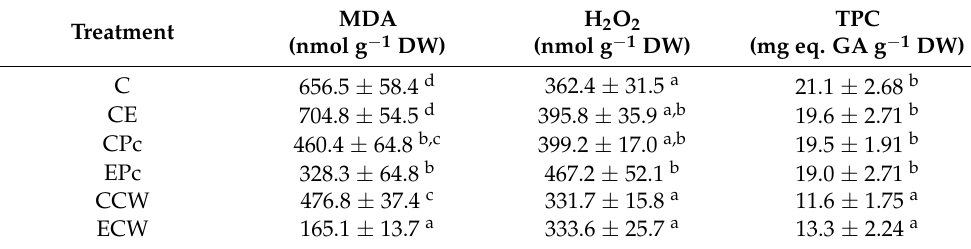
Table 6. Effect of soil treatments on oxidative stress markers and non-enzymatic antioxidants. MDA: malondialdehyde, H 2 O 2 : hydrogen peroxide, TPC: total phenolic compounds; GA: gallic acid, used as the standard in TPC determination. Treatments: Soil sampled in the Chinampa area was used as control (C); soil contaminated with endosulfan (CE); control soil bioremediated with Penicillium crustosum (CPc); endosulfan-contaminated soil, bioremediated with P. crustosum (EPc); control soil bioremediated with citric waste (CCW); endosulfan-contaminated soil, bioremediated with citric waste (ECW). Values represent the means of five replicas (five individual plants) followed by SD. Different letters in each column indicate significant differences between treatments, according to the Tukey test at the 99% confidence